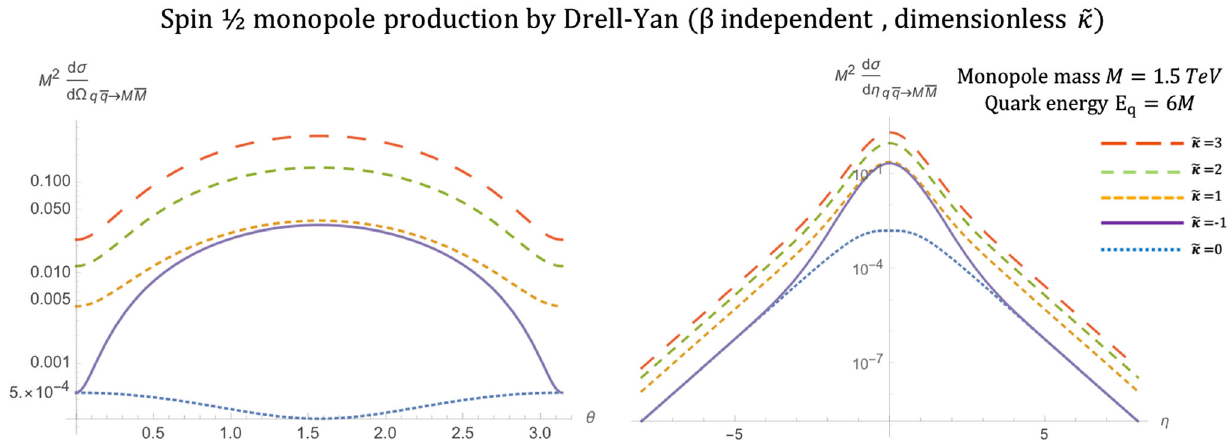
Fig. 12 Angular distributions for monopole-antimonopole pair pro- for various values of the parameter ˜ κ . The case ˜ κ = 0 represents the duction via DY for the case of a fermionic monopole with spin 1 / 2 and SM expectation for electron-positron pair production if the coupling is mass M = 1 . 5 TeV as a function of the scattering angle θ (left) and substituted for the electric charge e √ s qq = 2 E q , where E q = 6 M , and the pseudorapidity η (right) at